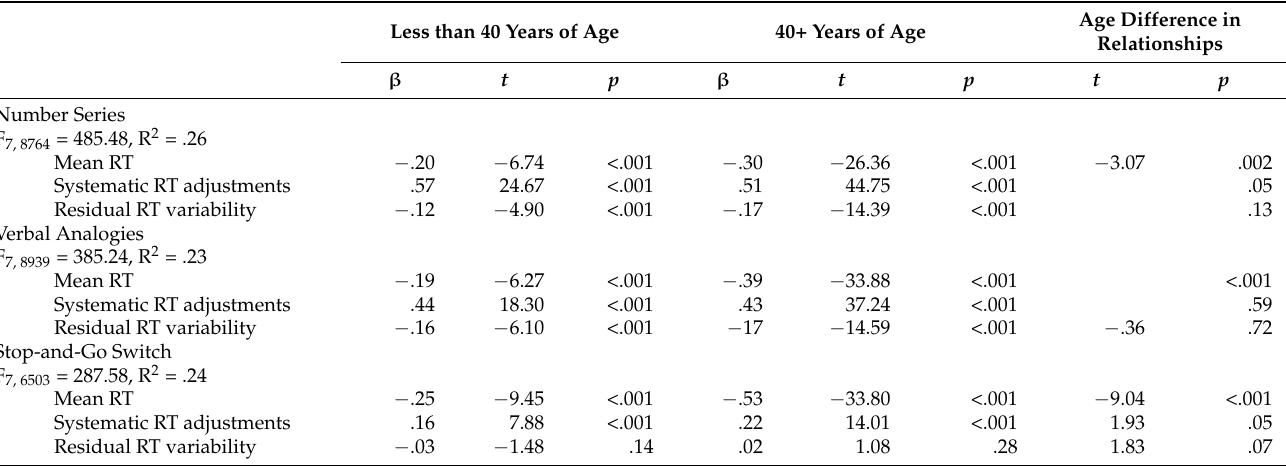
Table 5. Age differences in relationships between cognitive test scores and survey item response time components derived from the expanded location-scale